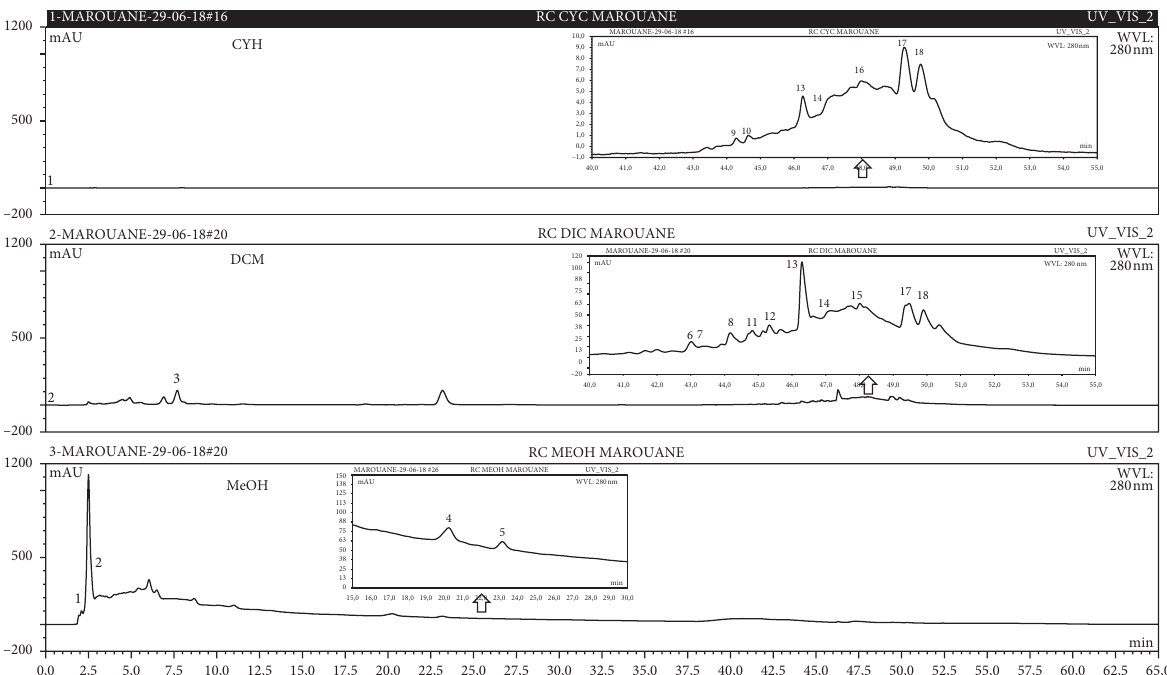
Figure 1: HPLC chromatograms profiles, visualized at 280nm, of. (CYH: cyclohexane; DCM: dichloromethane and MeOH: methanol) extracts obtained from aerial parts of R. crispus collected from Tunisia. Peaks: (1) 3-amino-4-hydroxybenzoic acid; (2) gallic acid; (3) 3, 4- dihydroxy-5 methoxybenzoic acid; (4) 7-hydroxycoumarin-3-carboxylic acid; (5) rutin hydrate; (6) butyl gallate; (7) 4-hydroxytamoxifen; (8) cardamonin; (9) phenoxodiol; (10) pinostilbene hydrate; (11) 3-benzyloxy-4, 5-dihydroxy-benzoic acid methyl ester; (12) ethyl trans-2- hydroxycinnamate; (13) 4 ′ , 5-dihydroxy-7-methoxyflavone; (14) pinosylvin monomethyl ether; (15) 3, 6, 3 ′ -trimethoxyflavone;